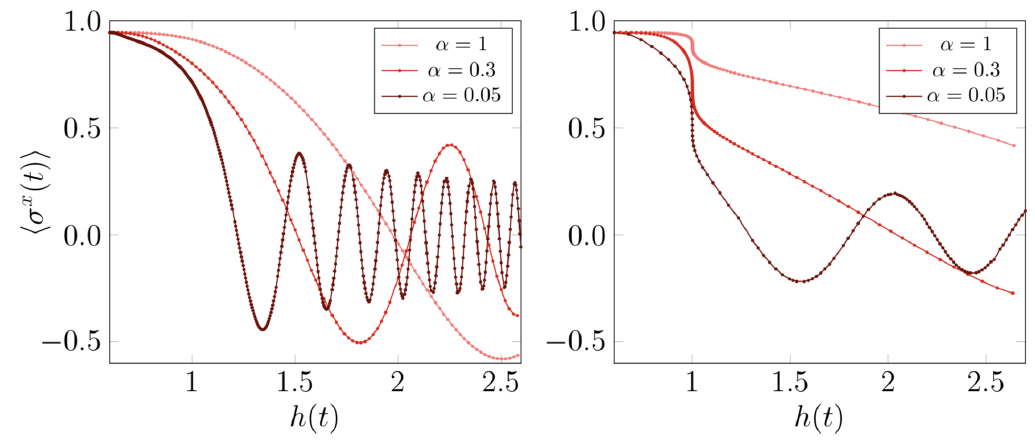
Figure 3: Order parameter expectation value 〈 σ x ( t ) 〉 as a function of h ( t ) , with a ramp crossing the critical point linearly h ( t ) = 0.6 + α t (left) and cubically h ( t ) = 1 + 6.25 × ( t α − 0.4 ) 3